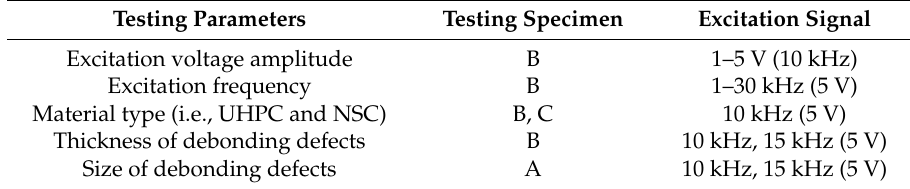
Table 4. Testing scenarios associated with wave propagation